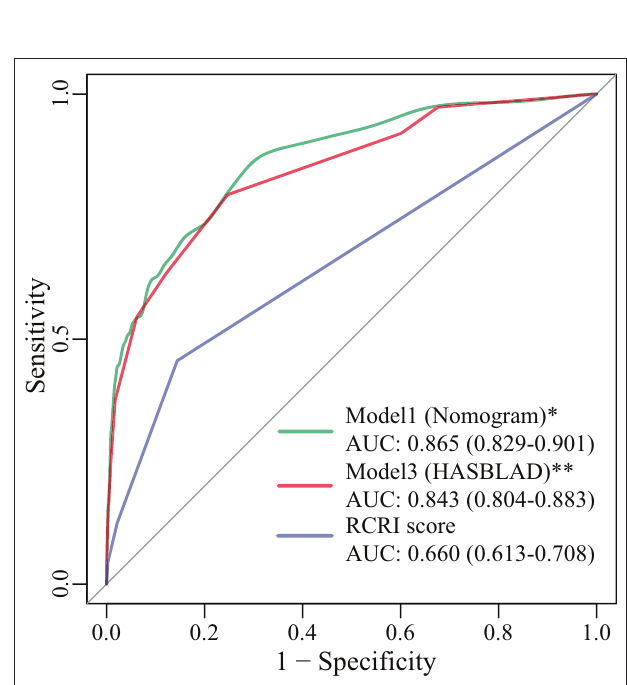
FIGURE 5 | Calibration curves of the Model 1 and the Model 3 in the derivation set. The left plot was the calibration curve of the Model 1 (Nomogram) in the derivation set. The right plot was the calibration curve of the Model 3 (HASBLAD) in the derivation set.